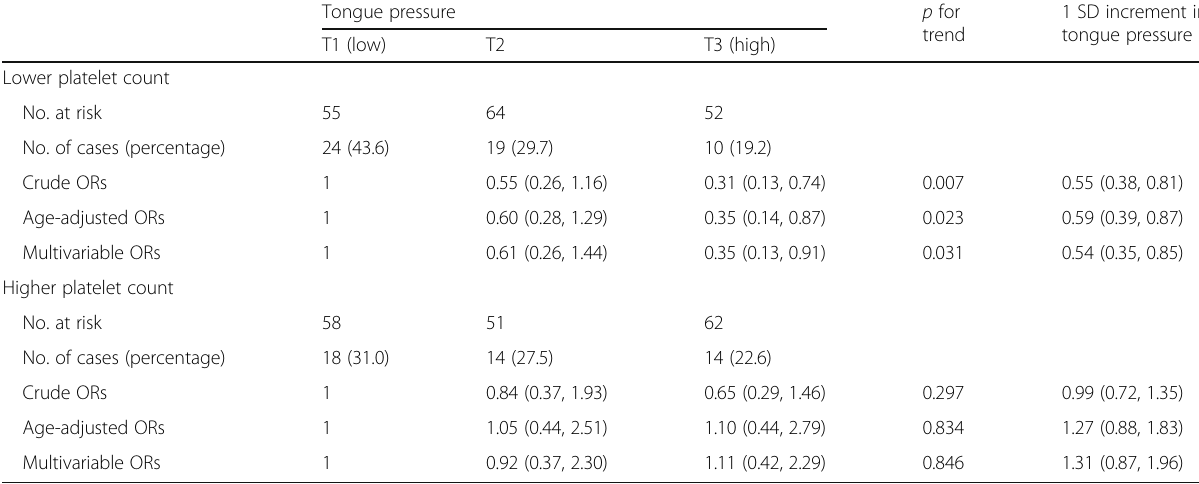
Table 4 Odds ratios (ORs) and 95% confidence intervals (CIs) for subclinical carotid atherosclerosis based on platelet level Tongue pressure